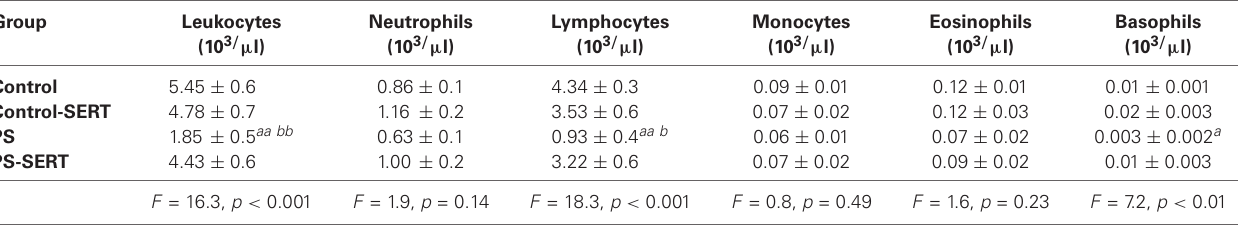
Table 2 | Plasma values obtained in the arterial blood in animals of both sexes (at P92) .